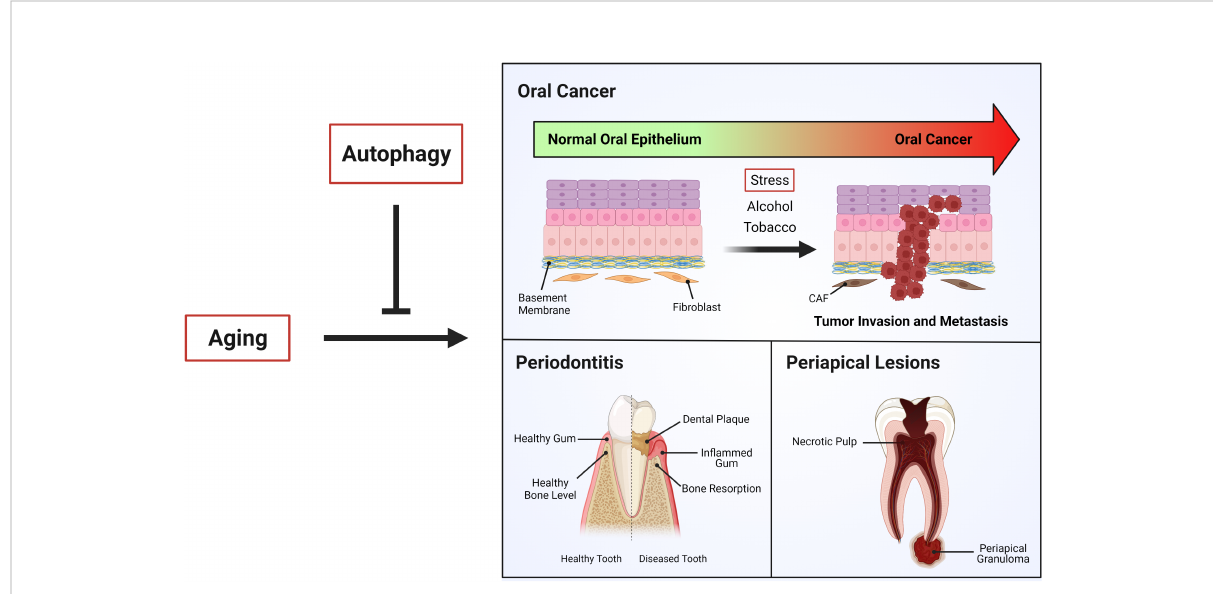
FIGURE 3 Autophagy and age-related oral diseases. Aging is a physiological process in which different cellular mechanism decline, leading in most of cases age-related diseases. “ Autophagy ” , which is impaired during aging, has been shown be critical to the control of age-related oral diseases such as oral cancer, periodontitis and periapical